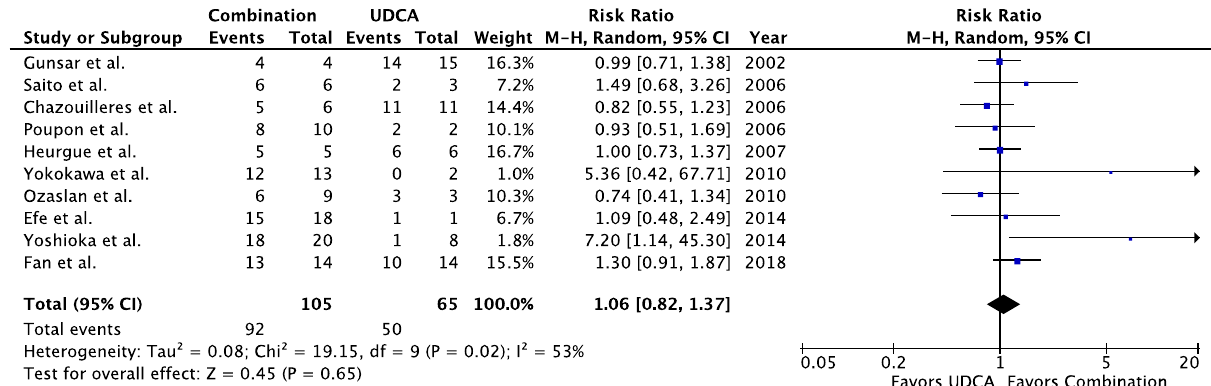
Figure 3. Non-progression of liver fibrosis in AIH-PBC patients treated with combination therapy vs. UDCA alone. UDCA = ursodeoxycholic acid, Combination = UDCA + corticosteroids ± AZA.